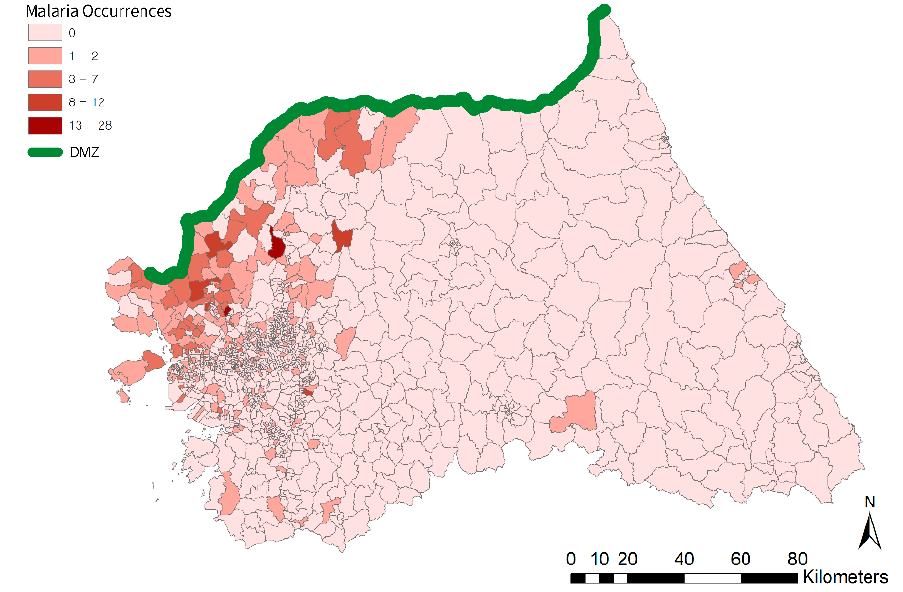
Figure 3. Map of malaria occurrences in South Korea in 2014.